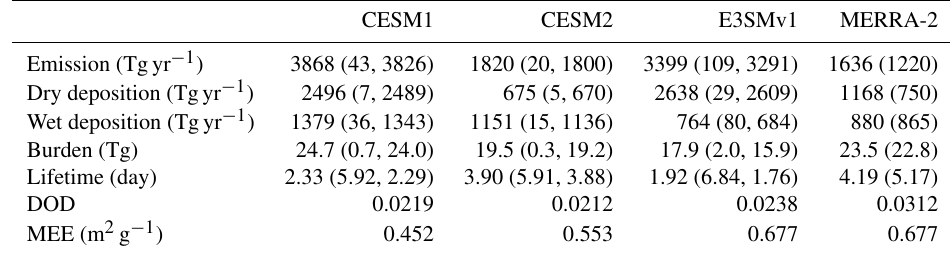
Table 2. Global annual mean dust mass budgets, DOD, and MEE.